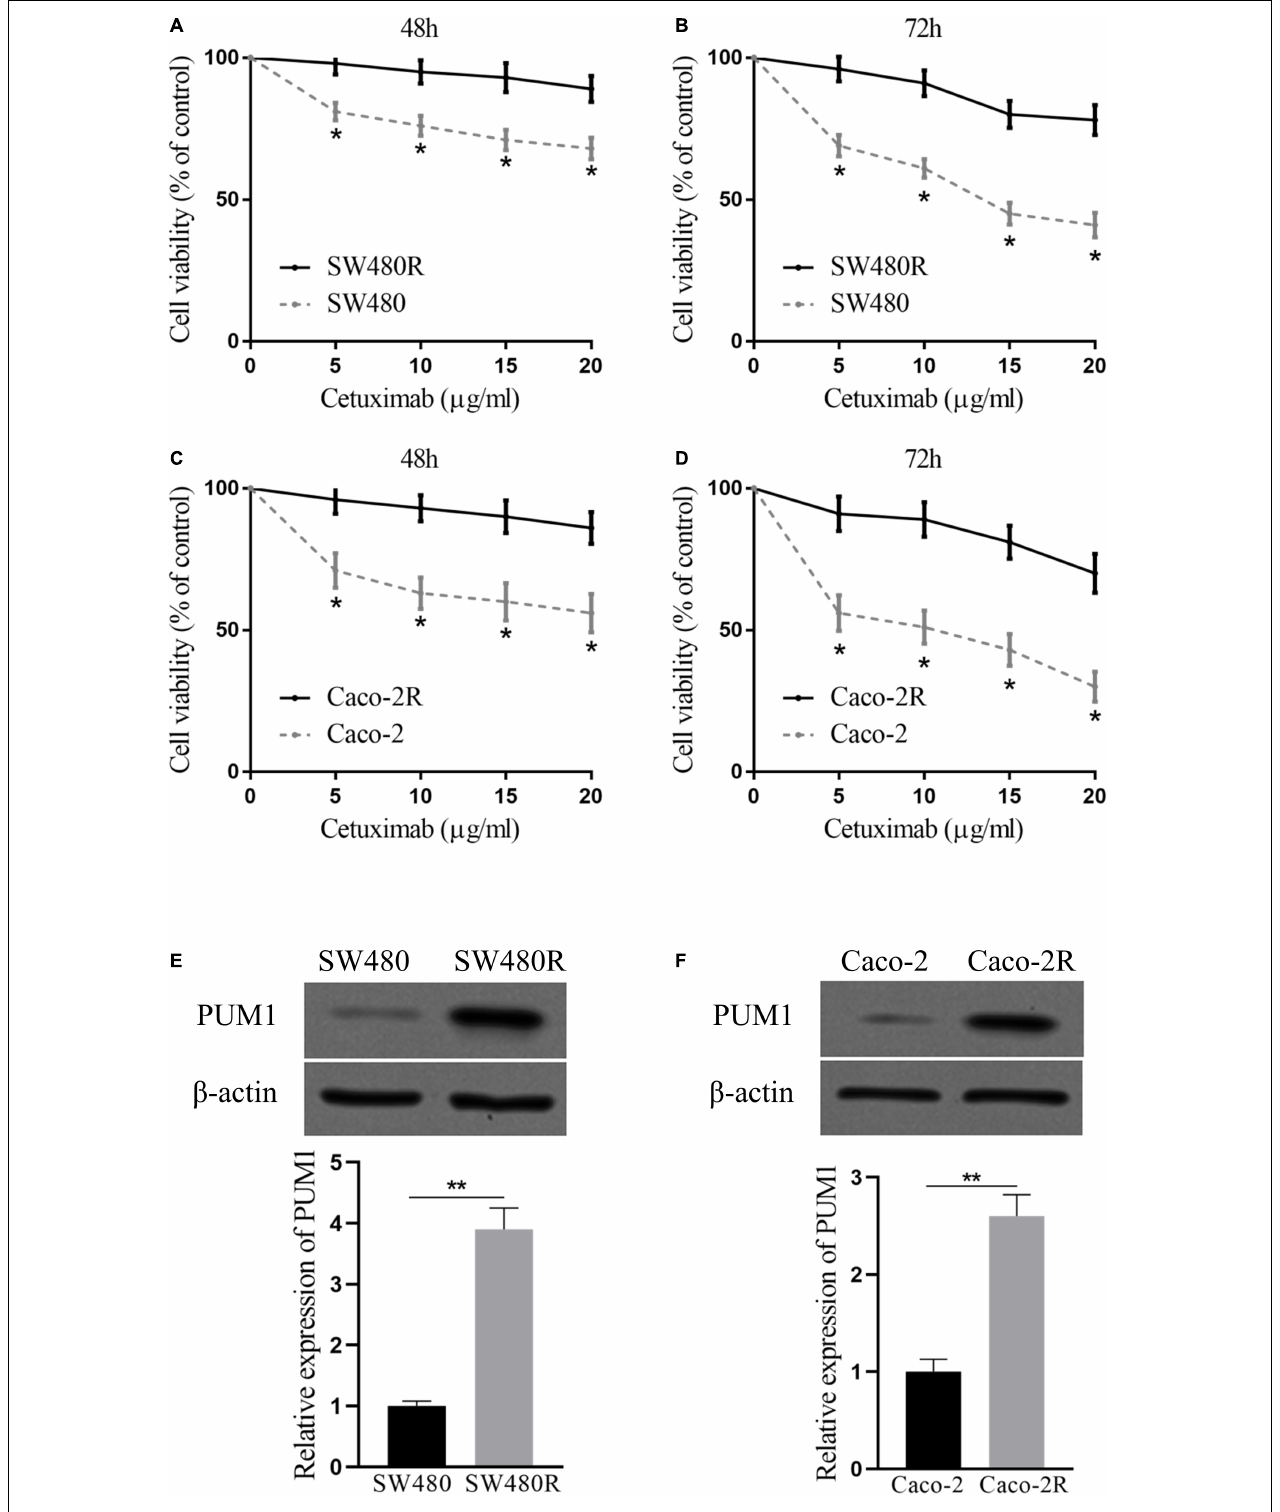
FIGURE 1 | Pumilio RNA-binding family member 1 (PUM1) is upregulated in cetuximab-resistant colon cancer cells. SW480 and SW480R cells were incubated with cetuximab for (A) 48 h and (B) 72 h, and cell proliferation was determined using the Cell Counting Kit-8 (CCK-8) assay. Caco-2 and Caco-2R cells were incubated with cetuximab for (C) 48 h and (D) 72 h, and cell proliferation was determined using the CCK-8 assay. (E,F) Western blot analysis of PUM1 levels in colon cancer cells. β -actin served as a loading control. Data were presented as mean ± SD of three independent experiments. * p < 0.05, ** p < 0.01.